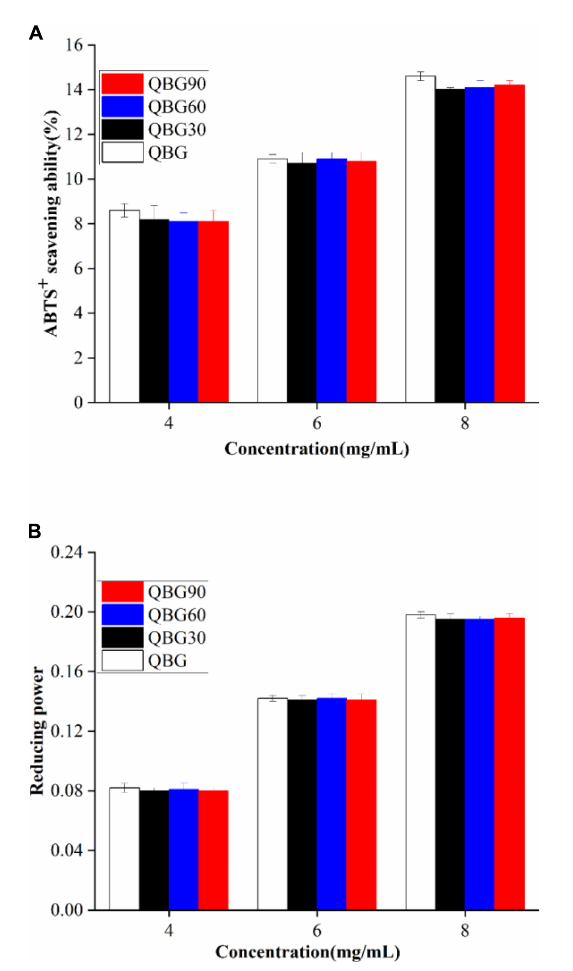
FIGURE5 The ABTS radical cation scavenging ability (A) and reducing power (B) of the Qingke β -glucan